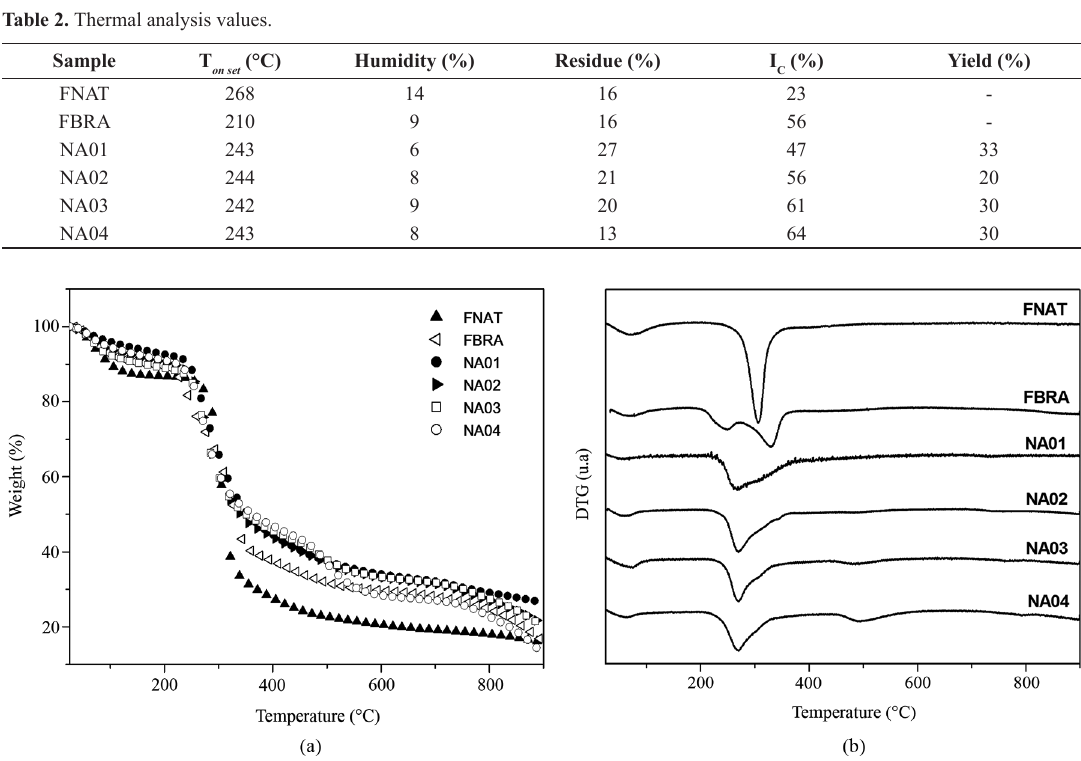
Figure 1. TG curves (a) and DTG (b) of the fiber in nature , bleached fiber and the cellulose nanowhiskers